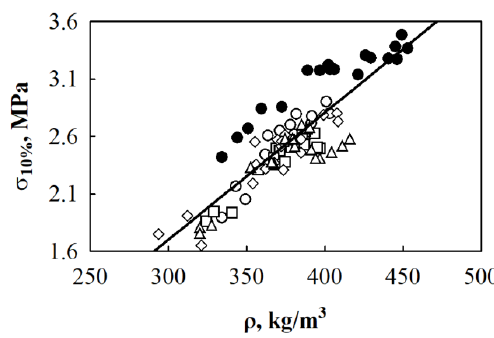
Figure 3. Relationship between compressive stress at 10% deformation and density where designated dots present experimental data for BcB from HS fraction, mm: ○ — 5/10; □— 10/20; ◊—2.5/20; ∆— 2.5/5; ●— shredded shivs; ( ─── ) — regression line.